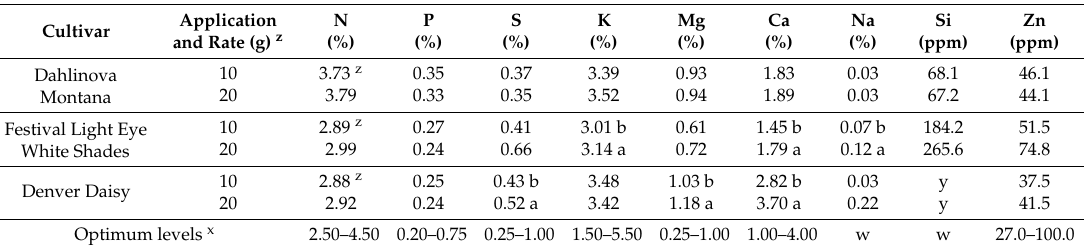
Table 8. Leaf nutrient content affected by irrigation, controlled by a tensiometer, across diatomaceous earth treatments in Dahlia × hybrida ‘Dahlinova Montana’, Gerbera jamesonii ‘Festival Light Eye White Shades’, and Rudbeckia hirta ‘Denver Daisy’.